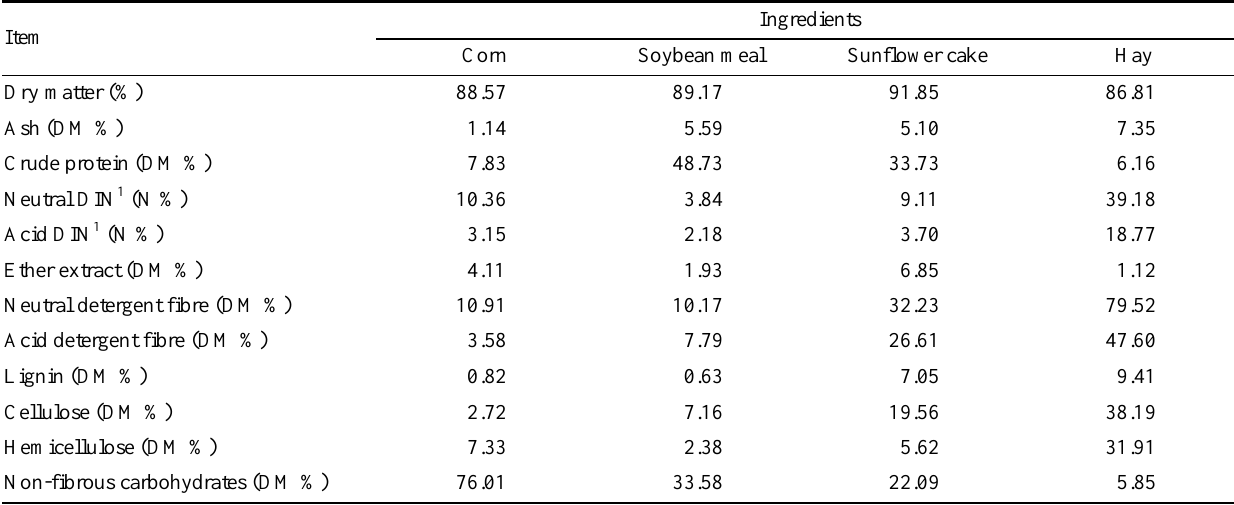
Table 1. Chemical composition of ingredients in diets fed to 1/2 Boer